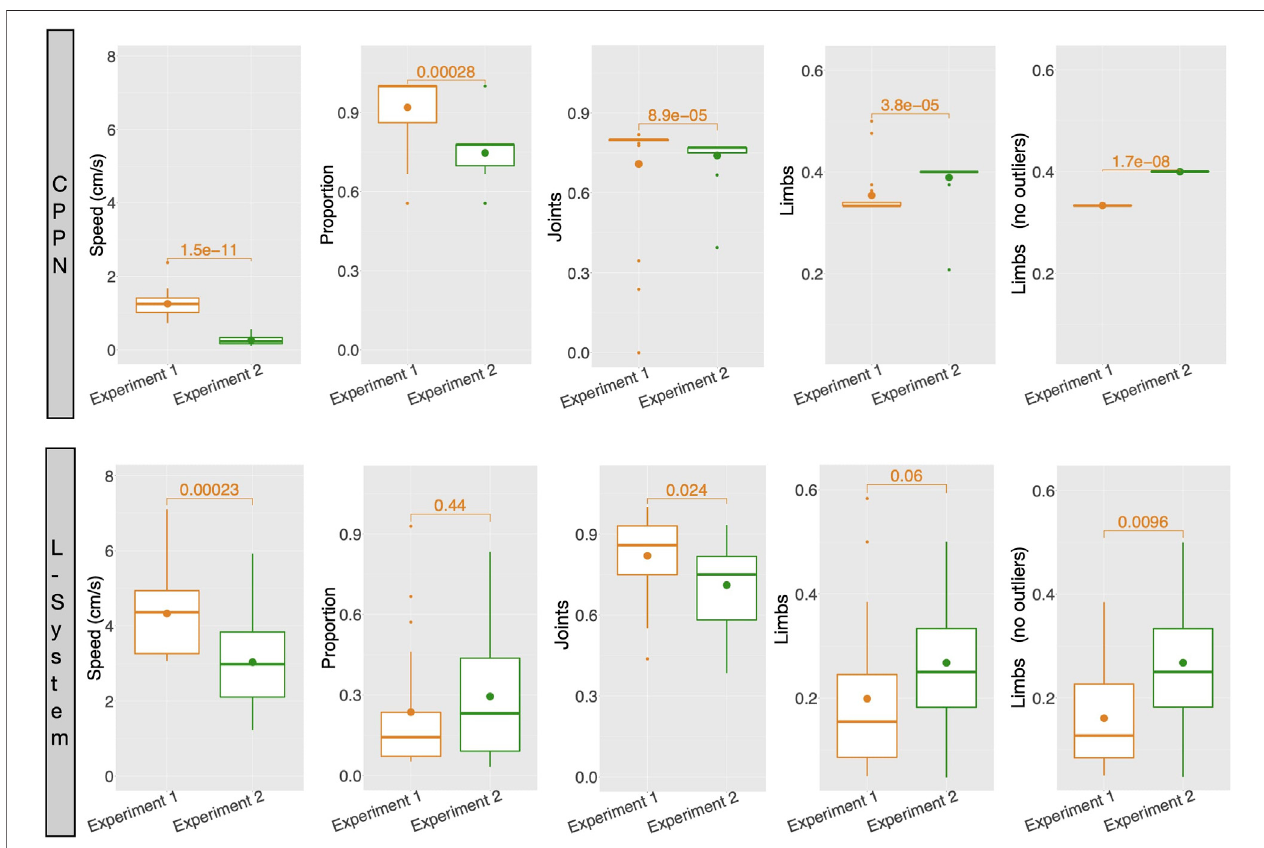
FIGURE 13 | Average robot traits among runs: for each run, includes all robots of the fi nal generation (149) aggregated using the median. Numbers above boxes are p values of Wilcoxon tests.